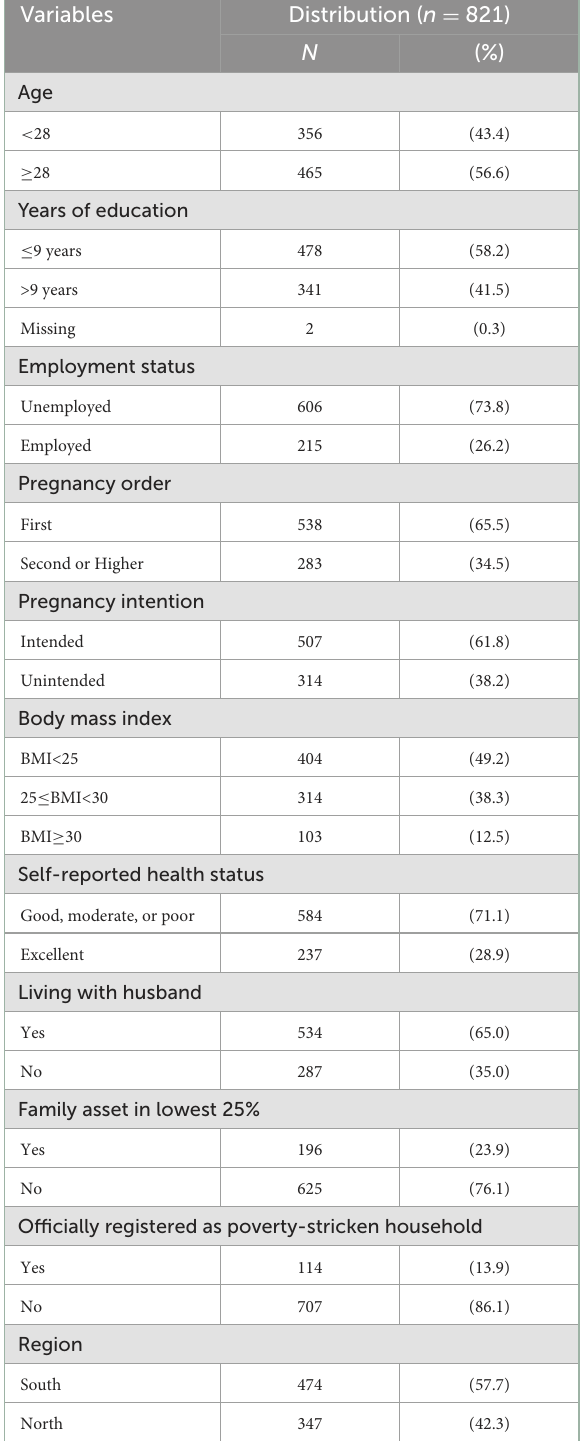
TABLE 1 Sociodemographic characteristics of study population.